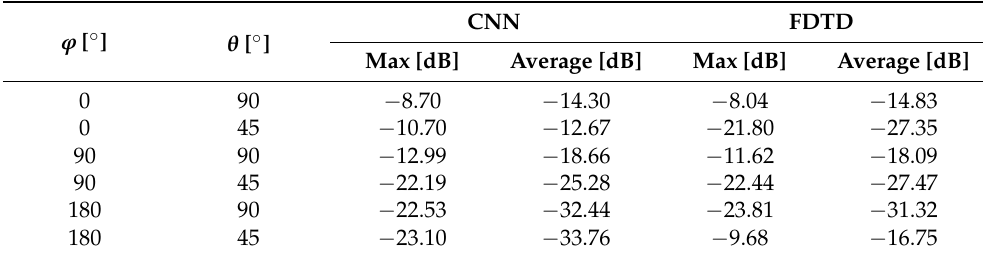
Table 5. Comparison between maximum and average values of power density obtained for the left eye